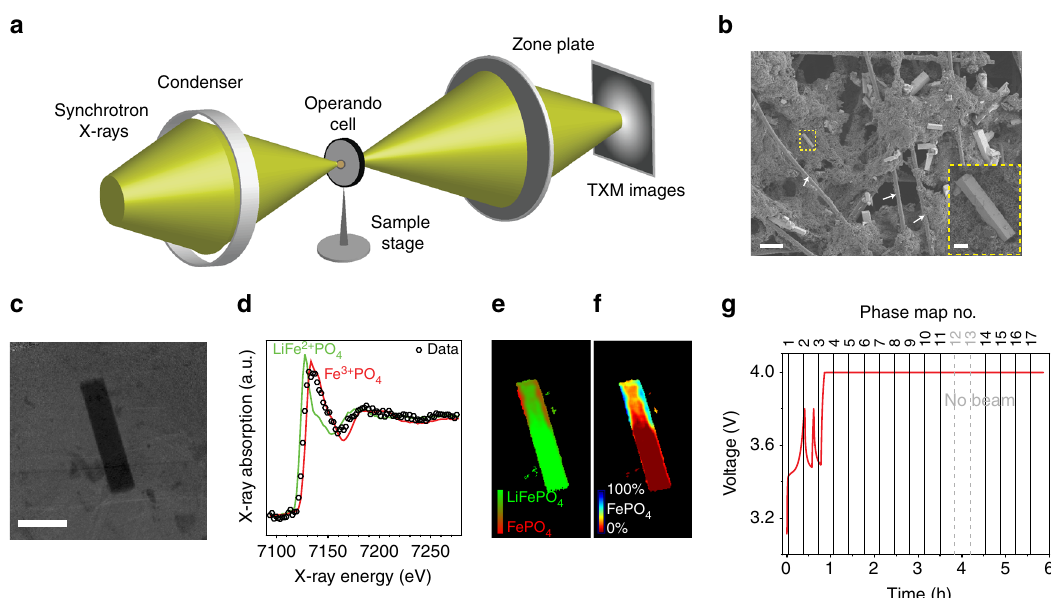
Fig. 2 Operando TXM-XANES experiments on LiFePO 4 electrode. a Schematic illustration of the TXM-XANES setup. b SEM image of the LiFePO 4 electrode used for the operando experiments, which is prepared by depositing LiFePO 4 microrods, carbon black, and PVDF binder onto a carbon paper made of carbon micro fi bers (indicated by the white arrows). The scale bar is 40 μ m. Inset is a high-magni fi cation view of a single LiFePO 4 microrod. The scale bar is 5 μ m. c 40 × 40 μ m (256 × 256 pixels) operando TXM view of the LiFePO 4 electrode, showing a single LiFePO 4 microrod in the presence of carbon black, PVDF binder, and liquid electrolyte. Scale bar is 10 μ m. d XANES spectrum collected from the operando experiment (black open circle) in comparison with